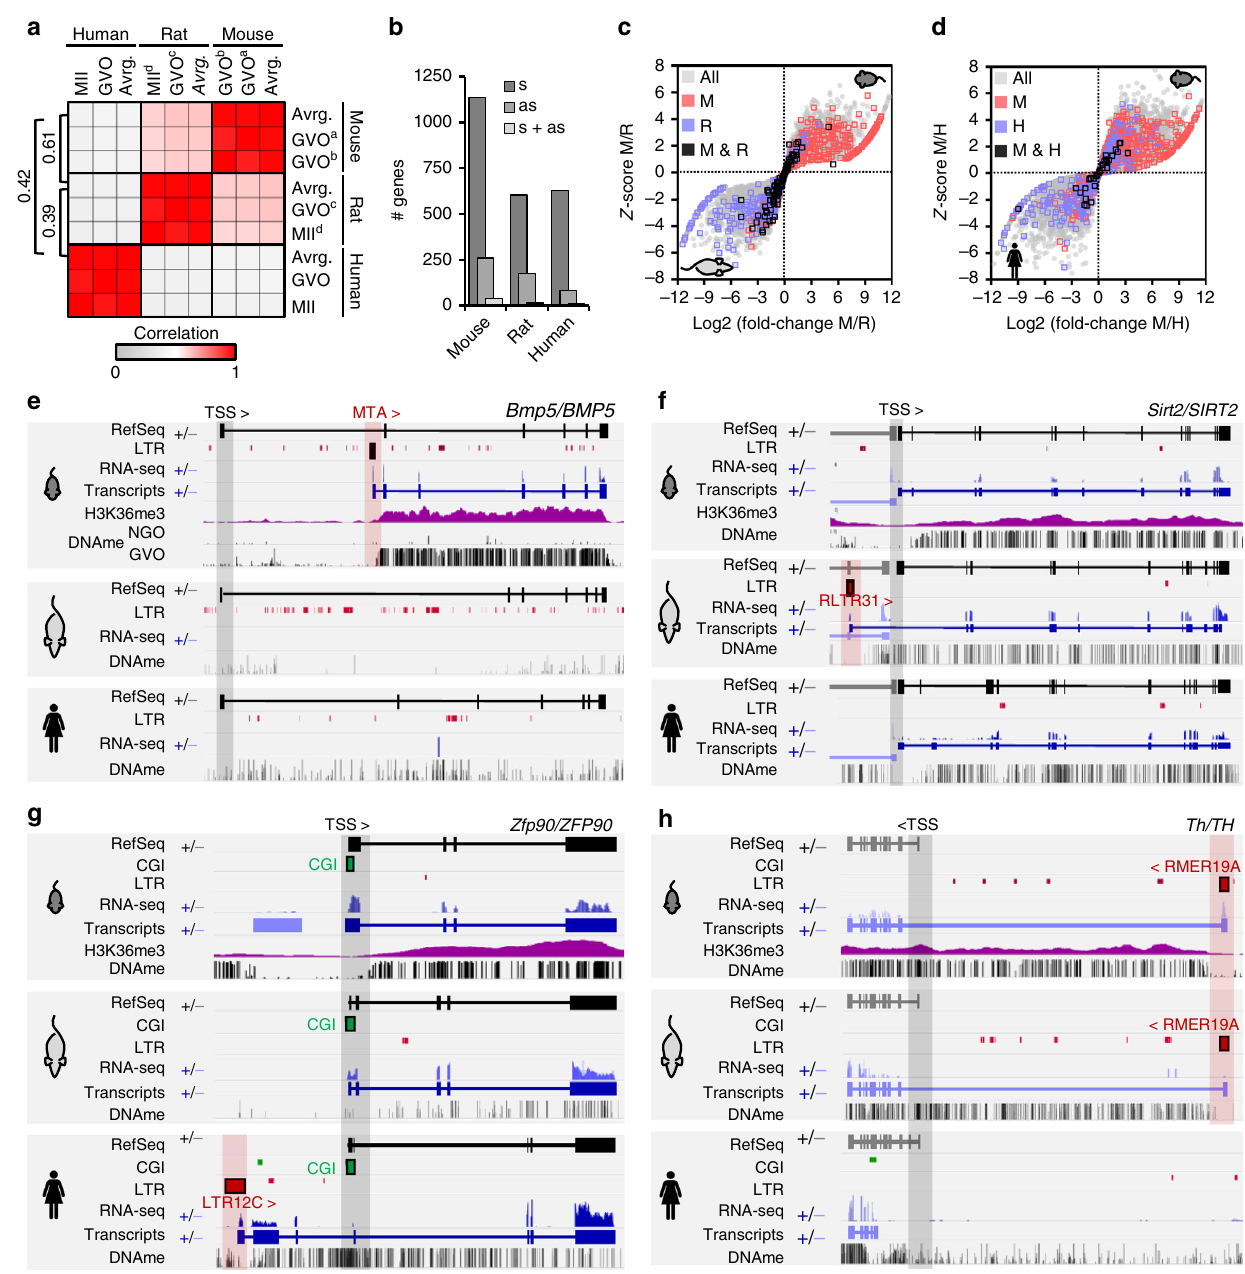
Fig. 3 LTR-initiated transcription impacts species-speci fi c gene transcription and gene body DNAme in oocytes. a Pearson correlation between mouse, rat, and human oocyte transcript levels over 11,186 syntenic Ensembl annotated genes. a C57BL/6, b Cast/Ei, c Sprague Dawley, d Wistar Han. b Number of annotated Ensembl genes with one or more overlapping LIT(s). s: sense overlap, splicing into a genic exon and >10% contribution to all of the gene ’ s isoforms, as antisense overlap. c Comparison of gene transcription between mouse and rat GVOs (gray). Highlighted are genes with an LTR-driven isoform that contributes to at least 10% of the gene transcripts in mouse (red), rat (blue), or in both species (black). d Comparison of gene transcription between mouse and human GVOs (gray). Highlighted are genes with an LTR-driven isoform that contributes to at least 10% of the gene transcripts in mouse (red), human (blue), or in both species (black). e Screenshot of the Bmp5/BMP5 locus. In mouse oocytes, transcription initiates from an intragenic MTA element, and gene body H3K36me3 and DNAme are observed only downstream of the MTA. Note that the ortholog is not transcribed in rat or human oocytes. f Screenshot of the Sirt2/SIRT2 locus. In rat oocytes, transcription initiates in an upstream RLTR31B2 element, and DNAme downstream of this alternative promoter encompasses the canonical Sirt2 promoter. In both mouse and human oocytes, the orthologous gene is transcribed from the canonical (hypomethylated) promoter. g Screenshot of the Zfp90/ZFP90 locus. A human-speci fi c isoform initiates in an LTR12C upstream of the canonical CGI promoter, which is hypermethylated exclusively in human oocytes. Zfp90 is transcribed from the canonical TSS in mouse and rat oocytes. h Screenshot of the Th locus showing an unannotated isoform that initiates in an RMER19A LTR- upstream of the canonical promoter exclusively in mouse and rat oocytes. DNAme extends downstream of the RMER19A TSS in both species, coincident with H3K36me3 in mouse, and encompasses the annotated Th TSS. Mouse and human WGBS datasets analyzed from refs. 12,16 and human RNA-seq data from ref.